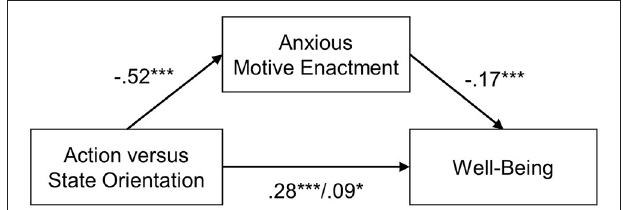
FIGURE 1 | Mediation model with the direct effect of action vs. state orientation on well-being and the indirect effect through anxious motive enactment. *limits of the 95% confidence interval do not include zero *** p <